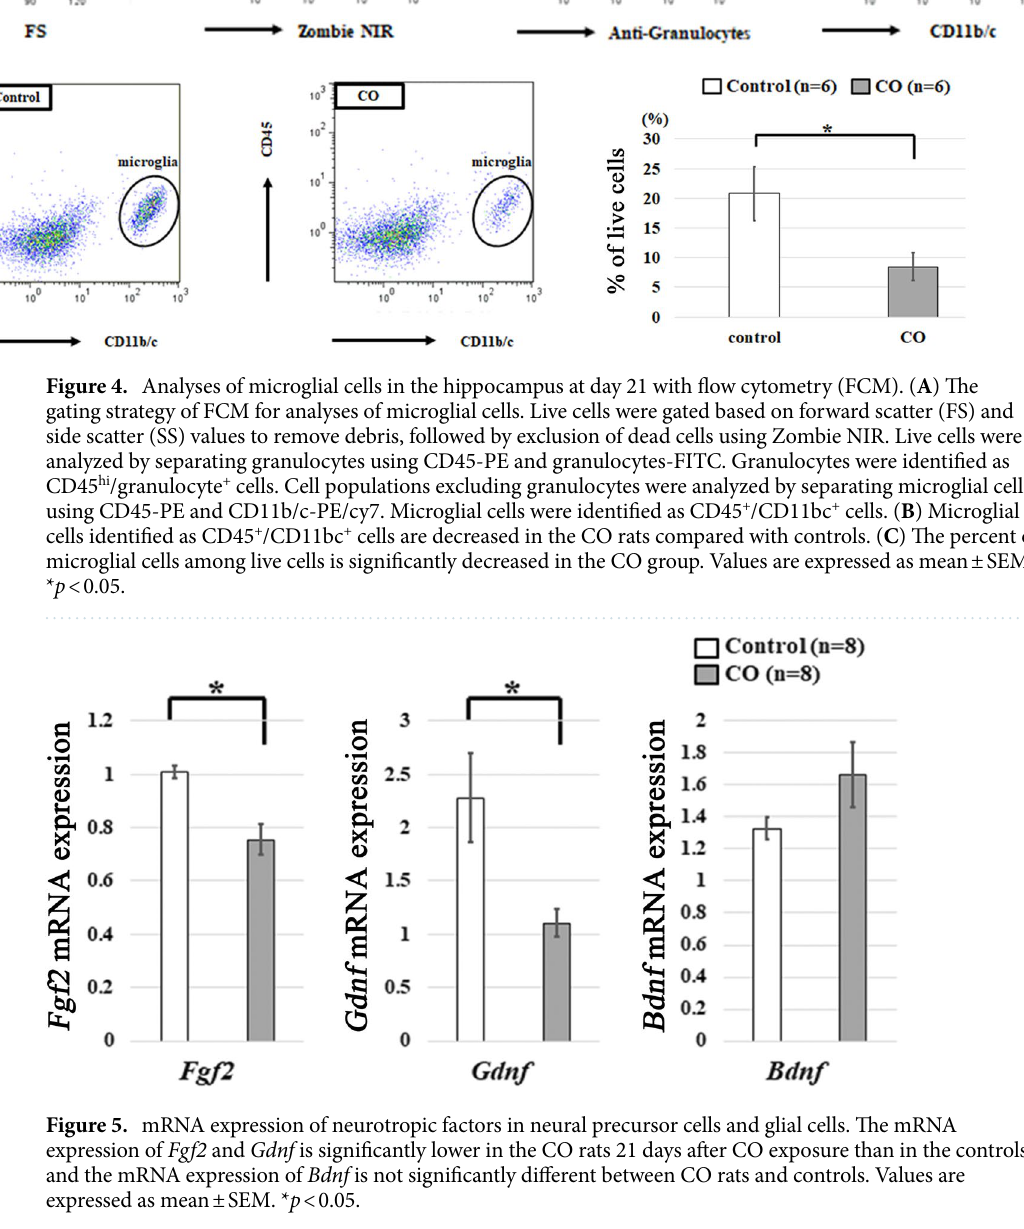
The results of both IHC and FCM analyses showed that CO exposure decreased the number of microglial cells. Activated microglial cells are considered to have negative effects on adult hippocampal neurogenesis because these cells secrete inflammatory factors, such as tumor necrosis factor-α, interleukin-1β, and interleukin-6, which induce apoptosis in neural precursor cells 30,31 . However, recent studies have shown that these inflamma- tory factors can increase the proliferation of neural precursor cells depending on the conditions 32,33 . Therefore, the decrease in microglial cells induced by CO exposure may be involved in the decrease in neural precur- sor cells induced by CO exposure. However, the relationship between microglial cells and adult hippocampal